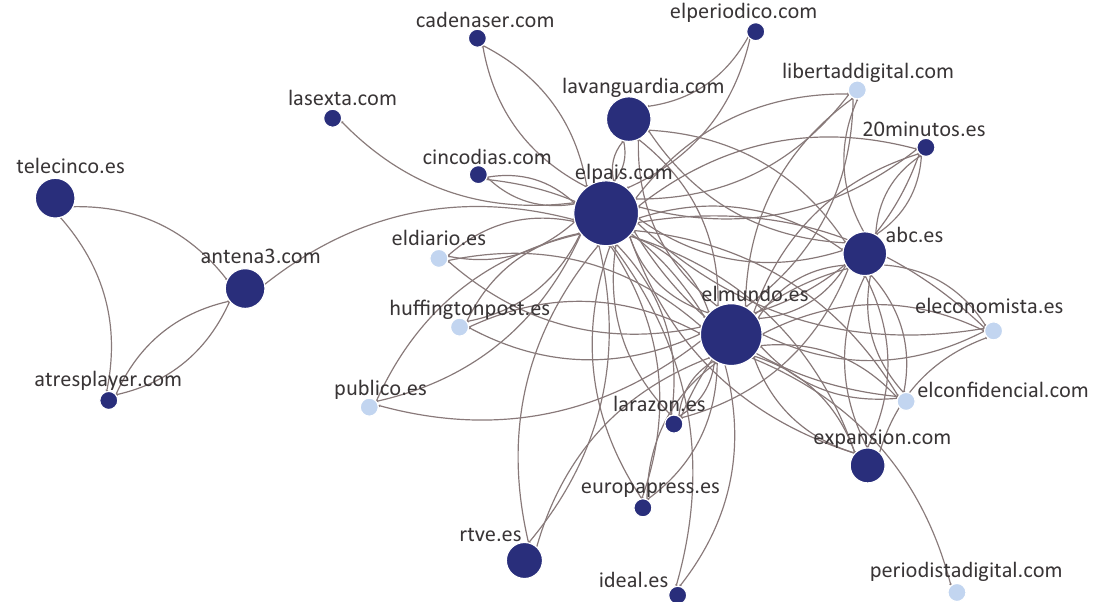
Figure 4. Audience brokers in the general audience